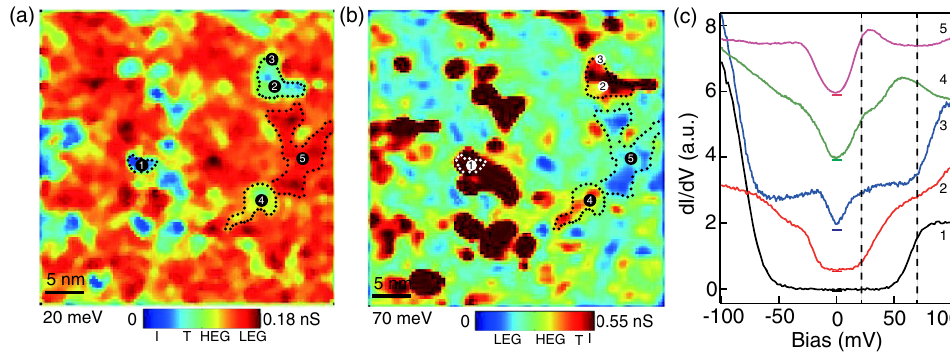
FIG. 2. Gap inhomogeneity of Sr 2 IrO 4 with 0.6 ML K taken at 20 K. (a,b) d I =d V maps taken at V b ¼ 20 meV and 70 meV, respectively. Representative areas with different electronic states are marked by dotted lines. Each map has 100 × 100 pixels. (c) Typical d I =d V spectra taken at the positions marked by dots in panels (a) and (b), showing the evolution of electronic states across the regions. The horizontal bars indicate the zero conductance position of each curve. Dashed lines located at 20 meV and 70 meV are added as guides to the eye. The labels I, T, HEG, and LEG on the color bars indicate the insulating, transition, HEG-dominated, and LEG-dominated regions,